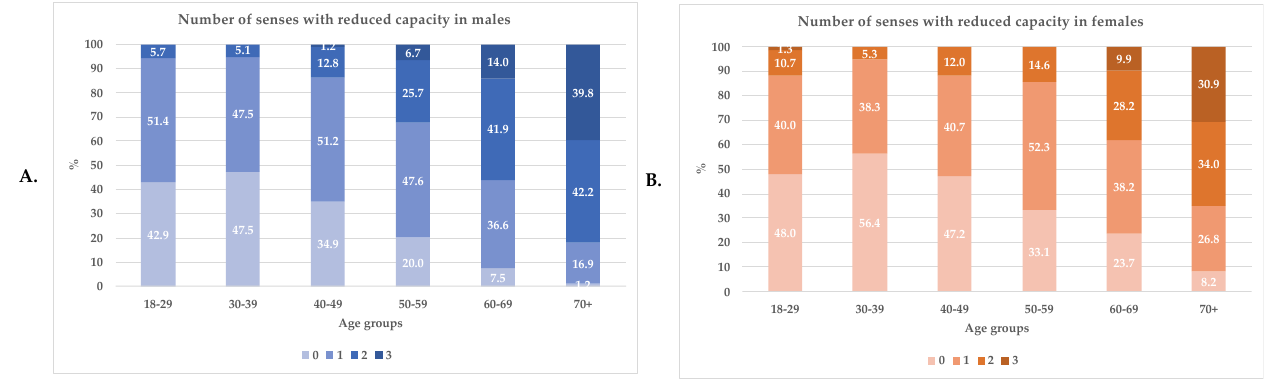
Figure 3. Prevalence of the number of senses with reduced capacities in males ( A ) and females ( B ) by 10-year age groups. The numbers above the bars are the prevalence. The colors indicate the number of senses with reduced capacities: the absence of sense with RC is indicated by the lighter color, the presence of three senses with RCs by the